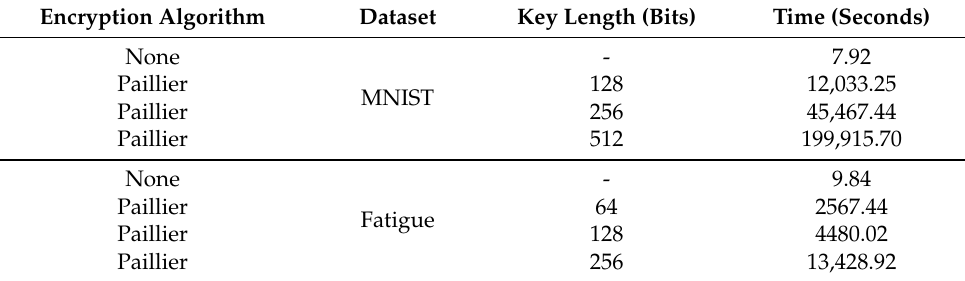
Table 5. Impact of different key lengths on total training